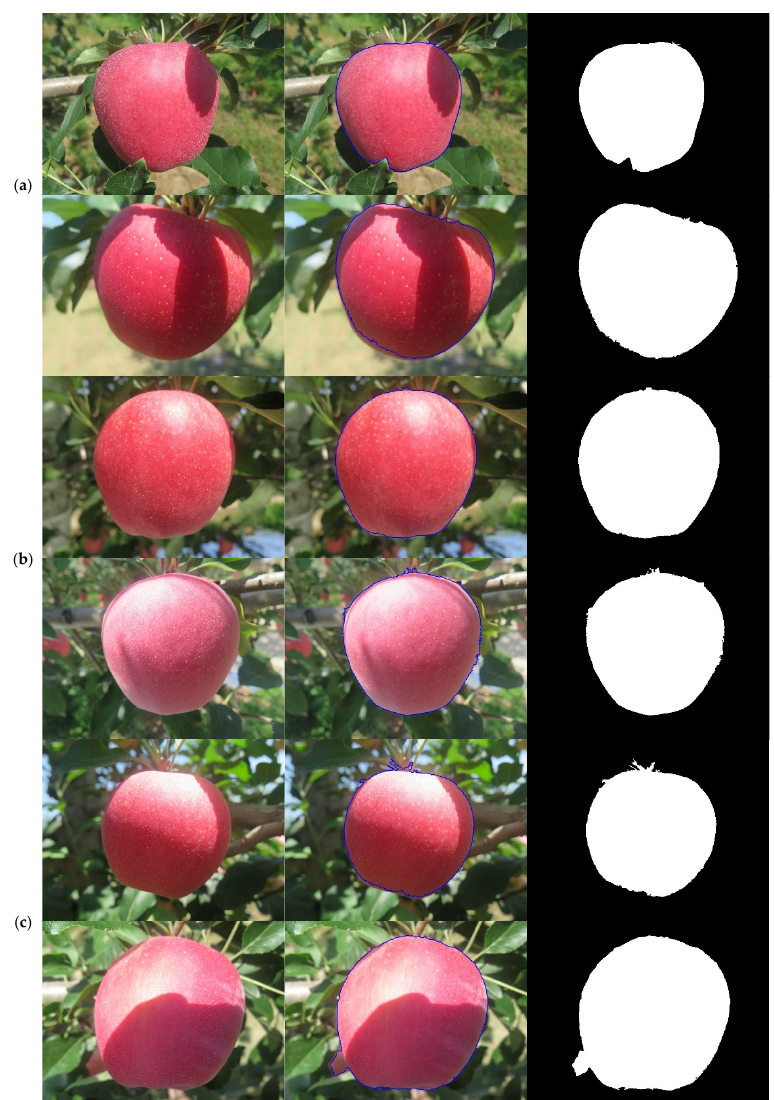
Figure 5. Visualizing the segmentation results: ( a ) light and heavy shadows, ( b ) strongly illuminated, ( c ) both shadows and light to varying degrees.